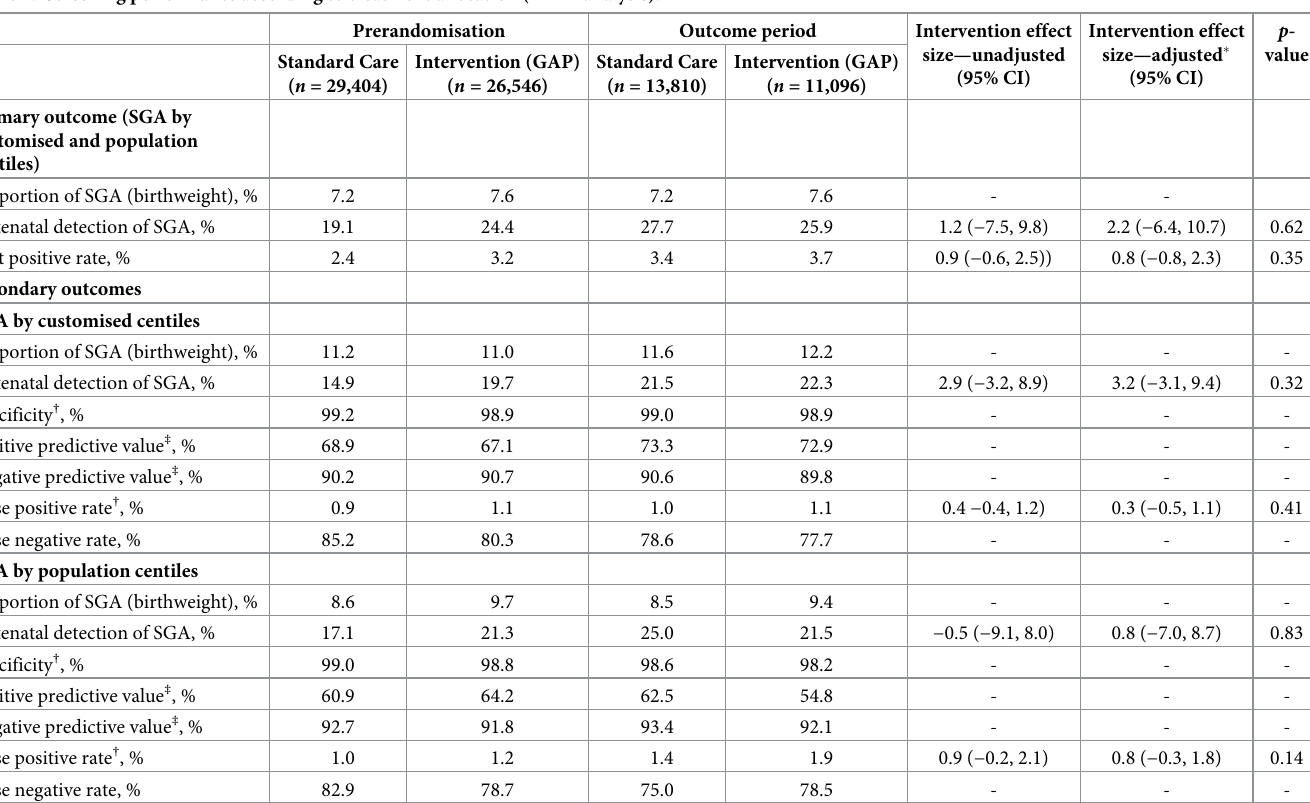
Table 4. Screening performance according to treatment allocation (mITT